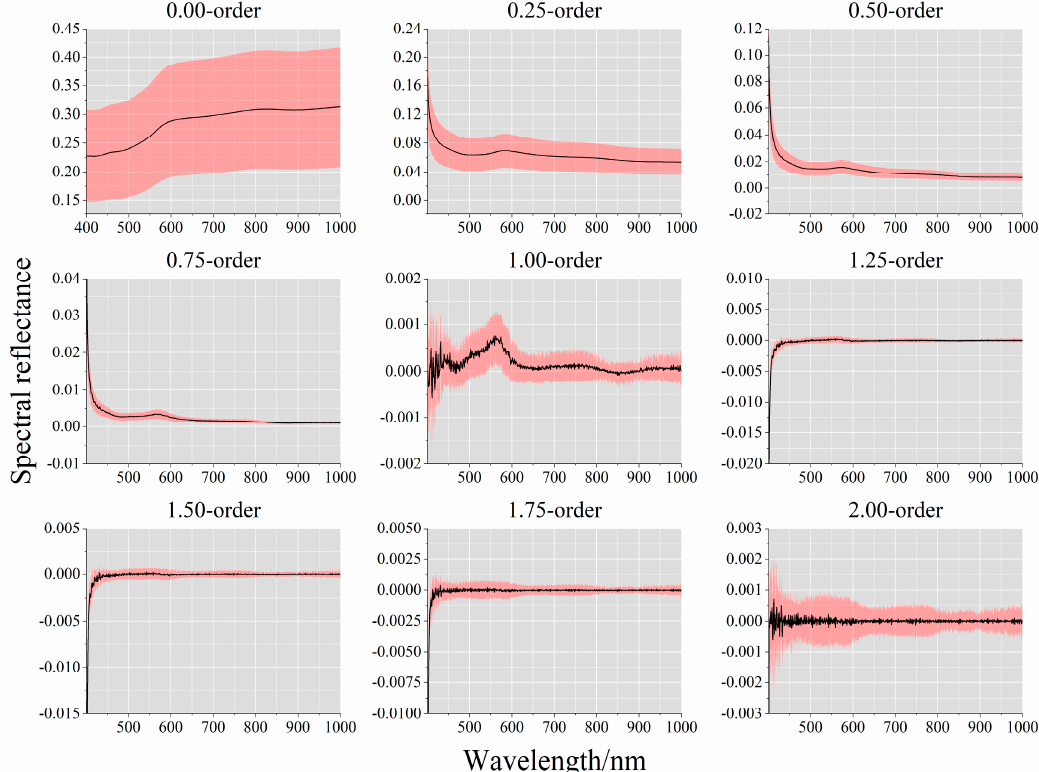
Figure 7. Soil spectrum curves of different fractional differential orders.